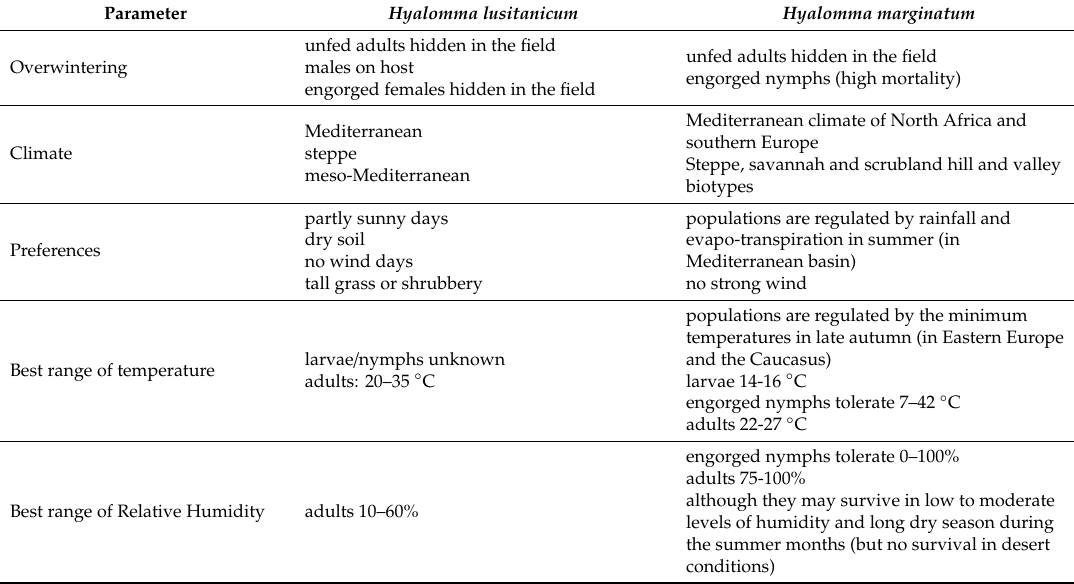
Table 5. Environmental preferences for field activity of Hyalomma lusitanicum and Hyalomma marginatum .